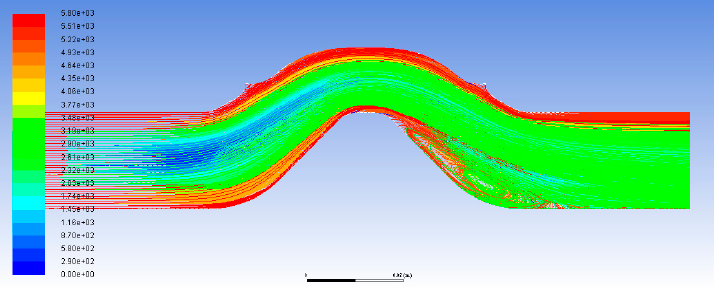
Figure 20. Streamline diagram of profile F at full opening.